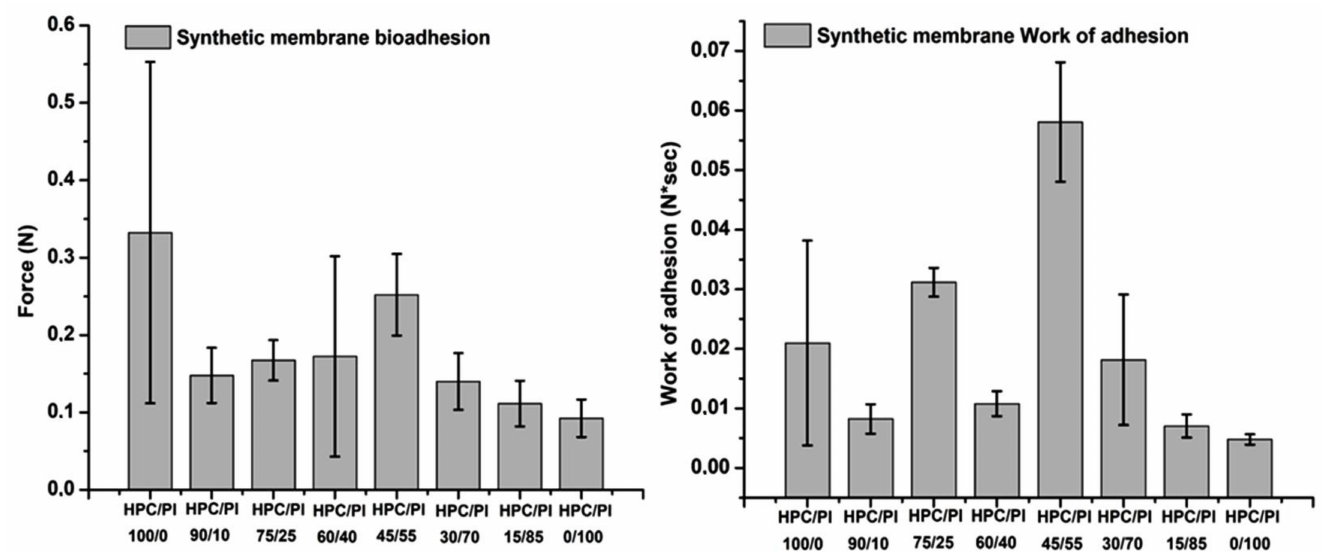
Figure 12. Bioadhesion evaluation of the studied blend scaffolds.